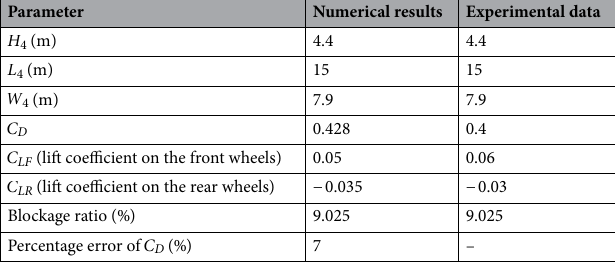
Figure 5. Grid dependency test.